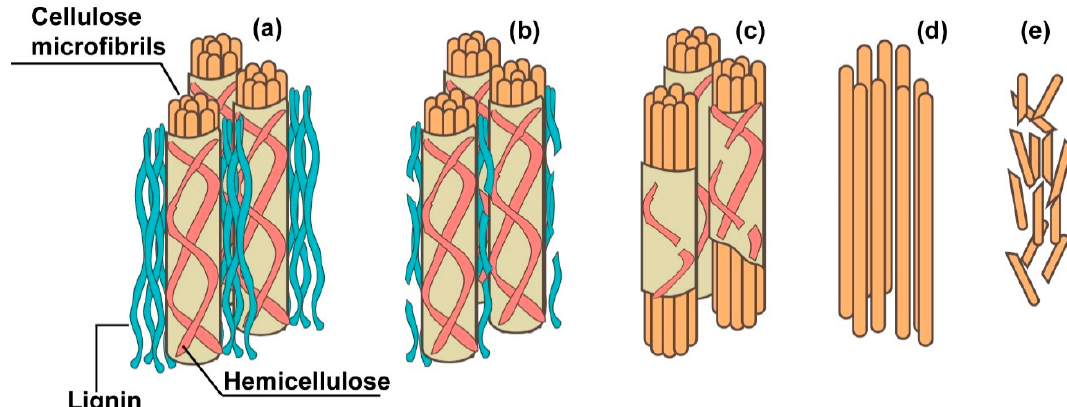
Figure 3. Schematic diagram showing the alkaline degradation mechanism of plant fibers. ( a ) Plant fiber compounds; ( b ) degradation of lignin and partly hemicellulose; ( c ) degradation of hemicellulose; ( d ) stripping of cellulose microfibrils; ( e ) failure of cellulose microfibrils. Based on reference [46].